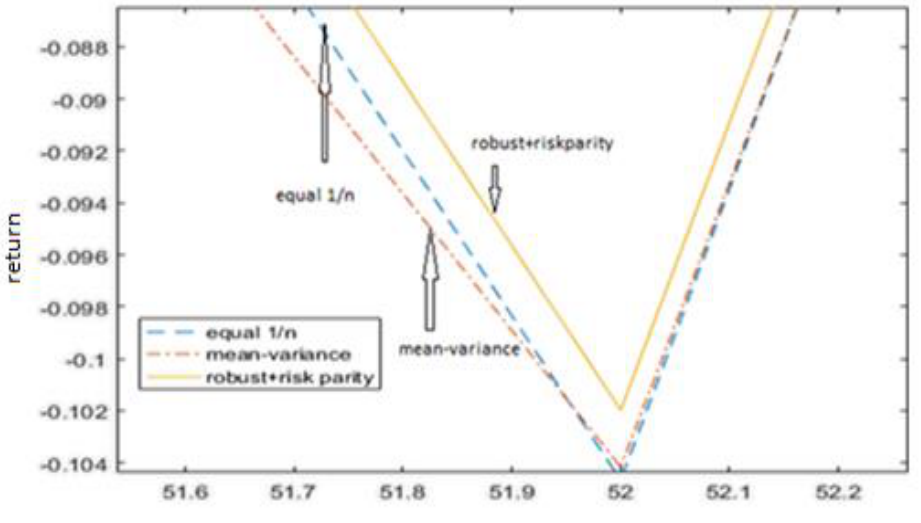
Figure 6. An example of the performance of portfolios in market shortfalls